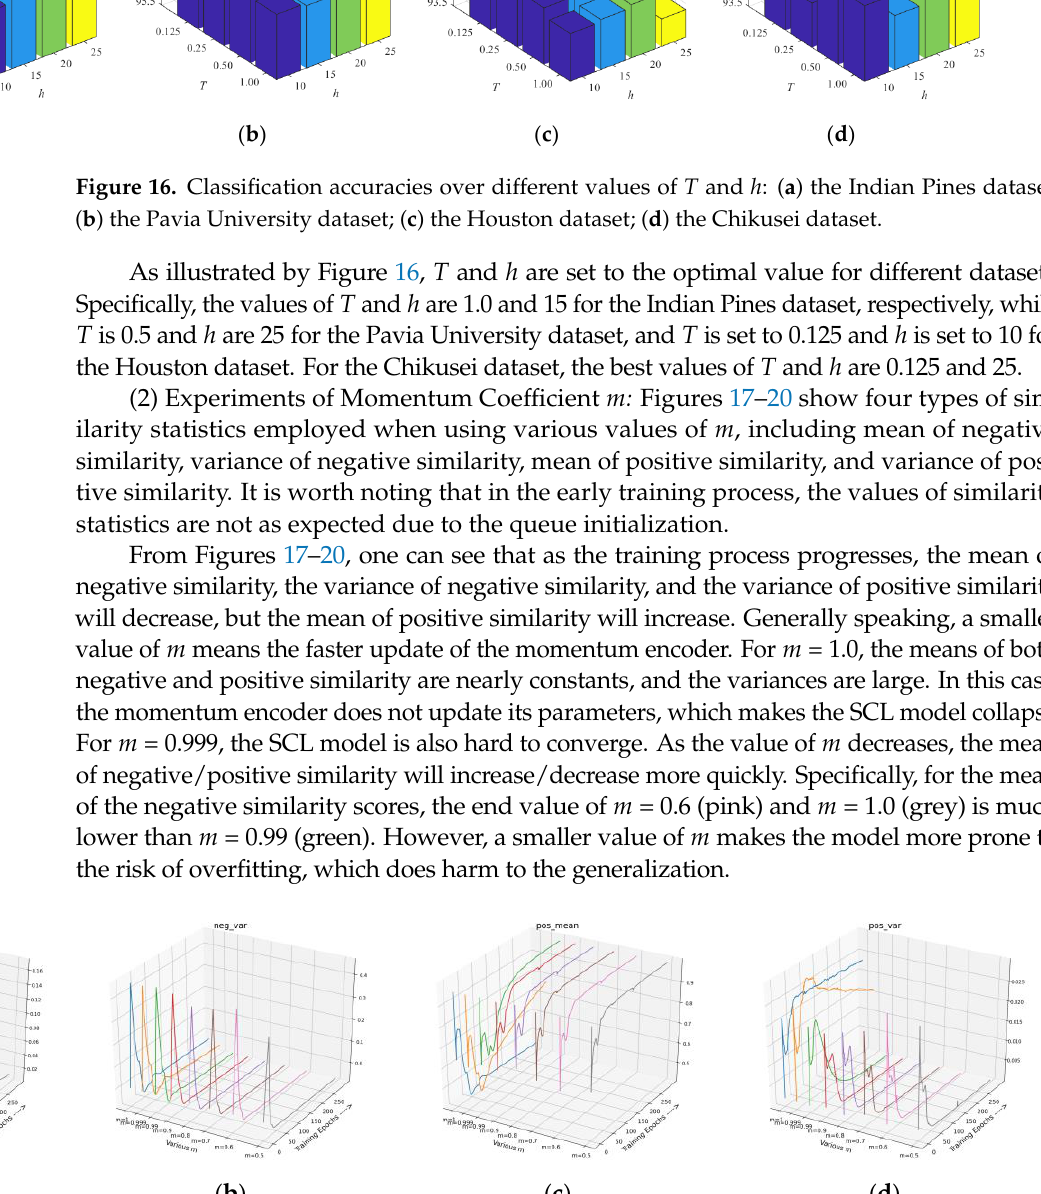
Figure 18. Similarity statistics of various 𝑚 in SCL training on the Pavia University dataset: ( a ) mean of negative similarity; ( b ) variance of negative similarity; ( c ) mean of positive similarity; ( d ) variance of positive similarity. Different colors corresponds to different values of 𝑚 .